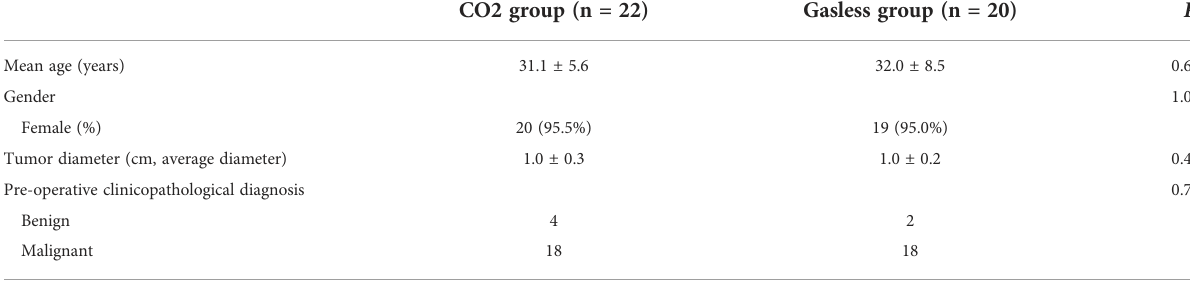
TABLE 1 Demographics and clinical characteristics of the two